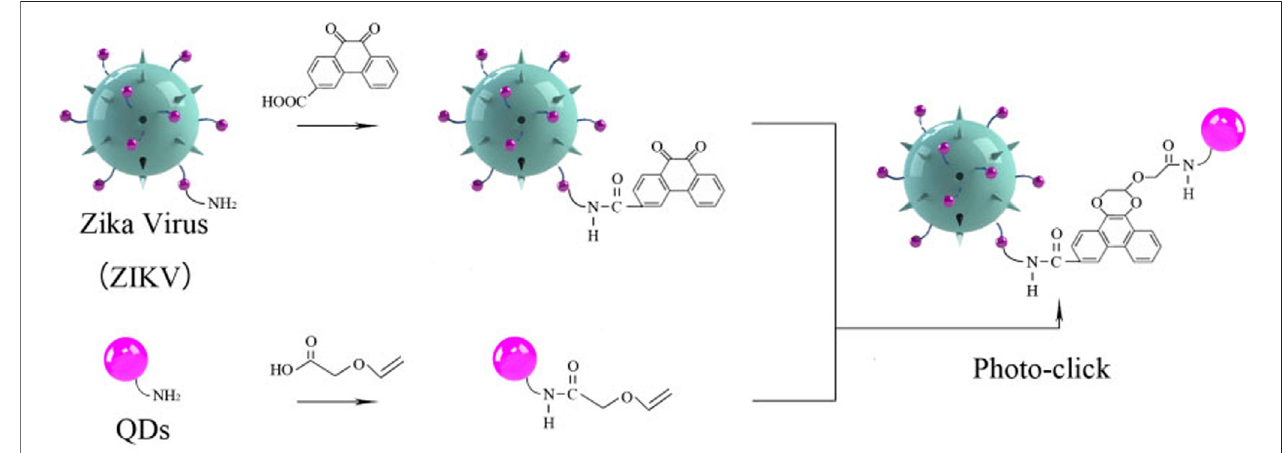
FIGURE 1 | Characterizations of Zika virus labeling and imaging via light-initiated bio-orthogonal photo-click cycloaddition. (A) Images of ZIKV and QD solution without (left) or with (right) the irradiation of the LED lamp. (B) Absorbance and fl uorescence changes of ZIKV and QDs in CH3CN/PBS solution upon irradiation treatment. (C) Polyacrylamide gel electrophoresis analysis of QDs and ZIKV-QDs. (D) Transmission electron microscopy (TEM) of QDs, ZIKV, and ZIKV-QDs.